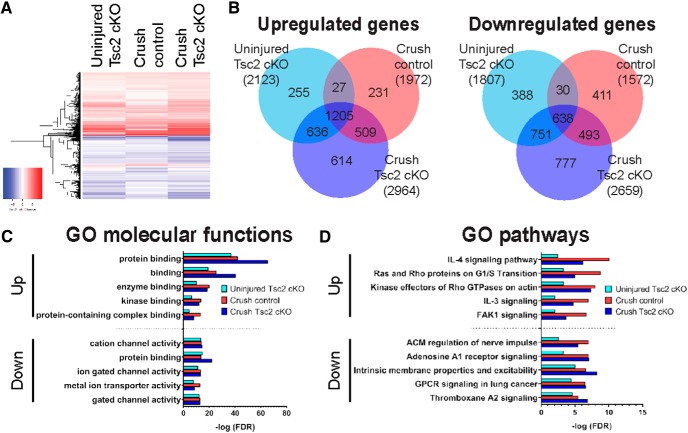
Similar molecular pathways are induced in Nav1.8-positive neurons by injury and by Tsc2 deletion. A, Heat map of differentially expressed genes in FACS-sorted, Nav1.8-positive neurons for each condition relative to uninjured control (n = 4 total; n = 2 male; n = 2 female; 8600 genes with adjusted p < 0.05 in at least one condition). B, Venn diagrams showing differentially expressed genes (adjusted p < 0.05, log2 fold change >0.5 or <–0.5) relative to uninjured control neurons for each condition. Total number of differentially expressed genes in each condition in parenthesis. C, D, Top five GO molecular functions and pathways categories differentially regulated in crush control neurons and Tsc2 cKO. Extended Data Figure 3-1 shows genes differentially expressed (adjusted p < 0.05, log2 fold change >0.5 or <–0.5) under at least one condition relative to uninjured control neurons.